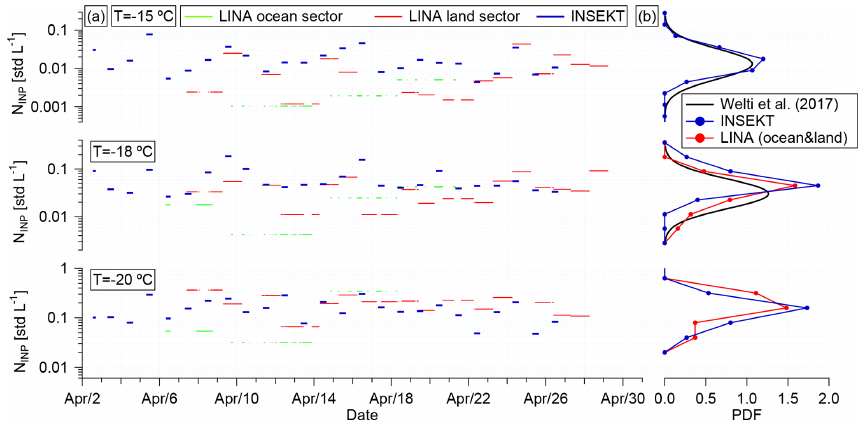
Figure 11. (a) Time series and (b) PDFs of N INP at − 15, − 18, and − 20 ◦